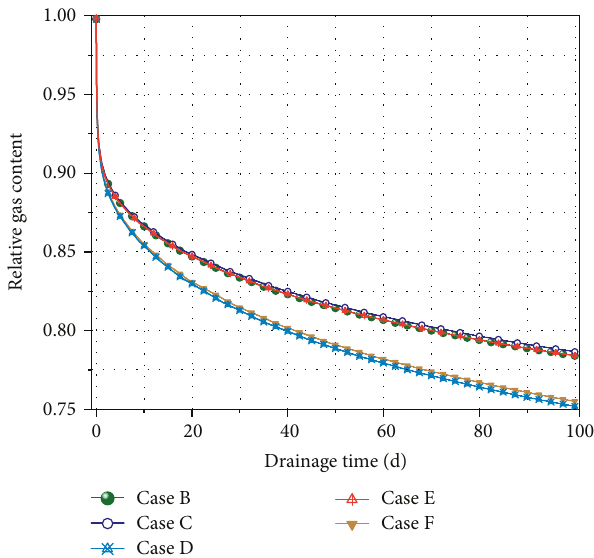
Figure 12: Impacts of the non-Darcy e ff ect, gas-coal interaction e ff ect, and Klinkenberg e ff ect on gas